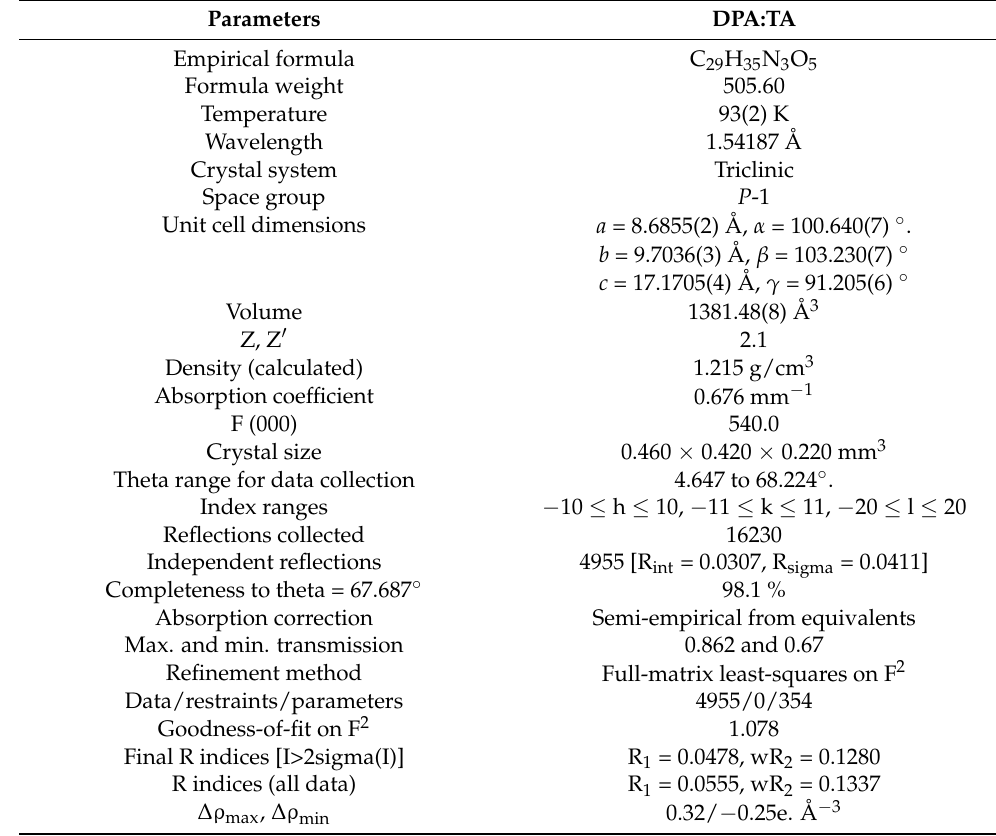
Table 1. Crystallographic data table for the DPA:TA